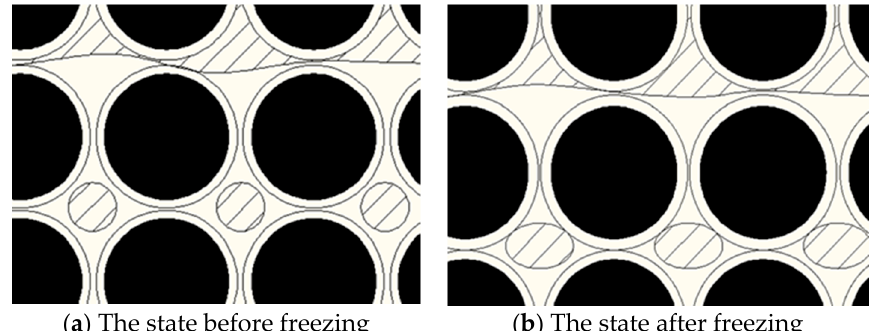
Figure 2. Schematic of freezing soil under a great temperature gradient: soil grains, the circles filled with black shadow; ice crystals, the circles or ellipses with slashed shadow; the ice block, the slashed shadow area; the thin unfrozen water film, the annulus outside the filled circle; the curve represents the potential position x sep of the ice lens; and the other symbols represent the unfrozen water.